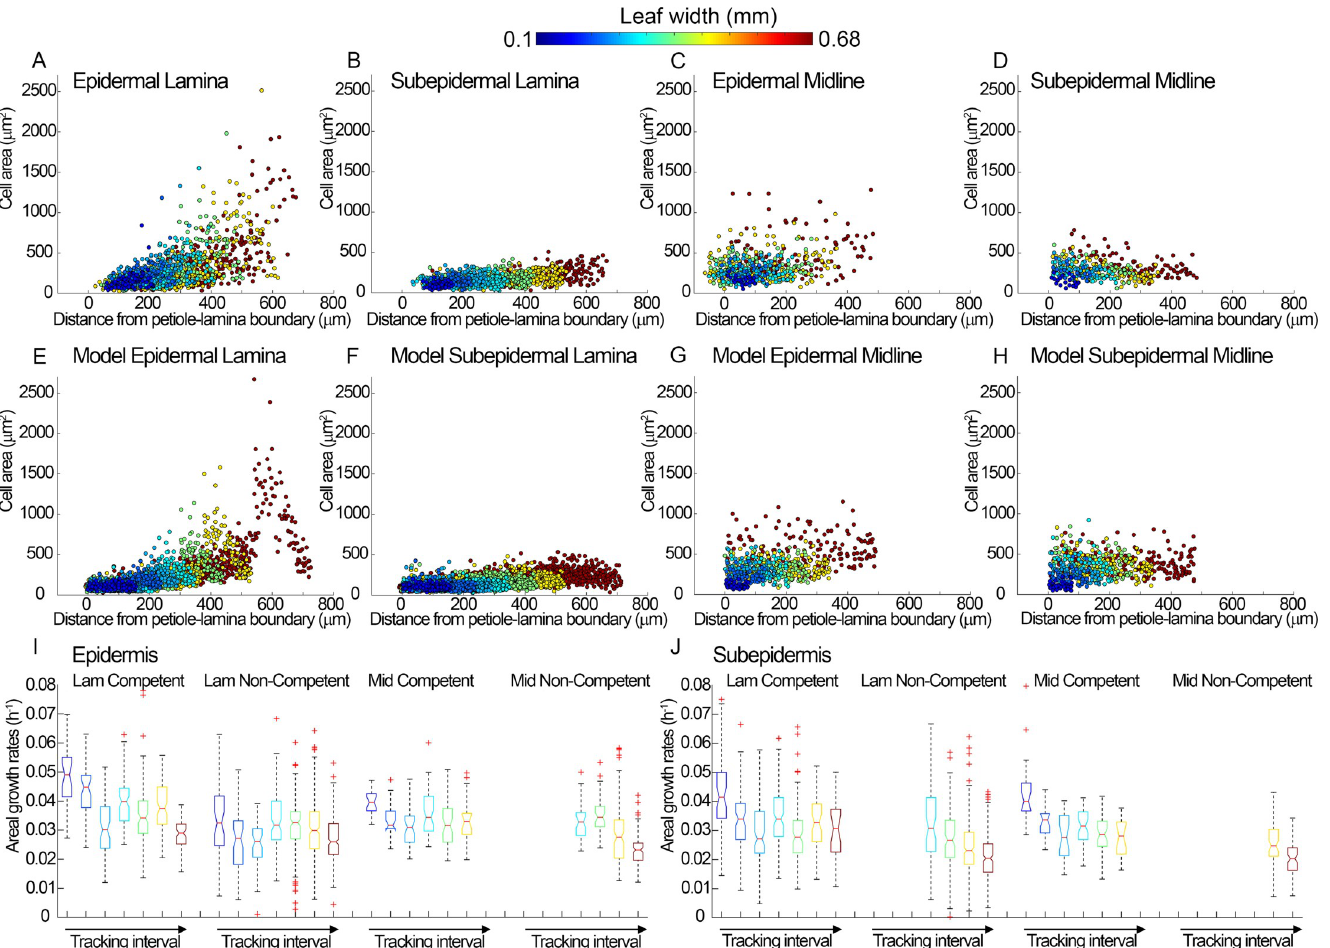
Fig 3. Quantification of cell areas and growth rates in epidermal and subepidermal data and models. ( A-D ) Data from cells amenable to tracking in the time-lapse experiment shown in Fig 1 and Fig 6. Data points are colour coded according to leaf width at the beginning of each time interval, as detailed in legend to Fig 1. ( A ) Epidermal cells in the lamina. ( B ) Subepidermal cells in the lamina. ( C ) Epidermal cells in the midline. ( D ) Subepidermal cells in the midline. ( E-H ) Output from epidermal and subepidermal models. ( E ) v-cells in the lamina of the epidermal model. ( F ) v-cells in the lamina of the subepidermal model. ( G ) v-cells in the midline of the epidermal model. ( H ) v-cells in the midline of the subepidermal model. Model data points are colour coded according to leaf width at equivalent stages to the data. ( I-J ) Areal growth rates of tracked cells in the lamina (Lam) and midline (Mid) regions, according to whether they were competent to divide or not competent to divide for the ( I ) epidermis and ( J ) subepidermis. Data are grouped according to tracking interval (as in Fig 1); colours represent leaf widths at the start of each interval (as for A-D). Boxes represent the central 50% of the data, with top and bottom at the 25% and 75% quantiles of the data. Central red lines represent the median of the data, and two medians are significantly different (at a 5% significance level) if their notches overlap. Outliers are shown as red crosses. Data with a sample size less than 15 are omitted. Source data are available from https://figshare.com/s/b14c8e6cb1fc5135dd87. Lam, lamina; Mid, midline; v-cell, virtual cell.